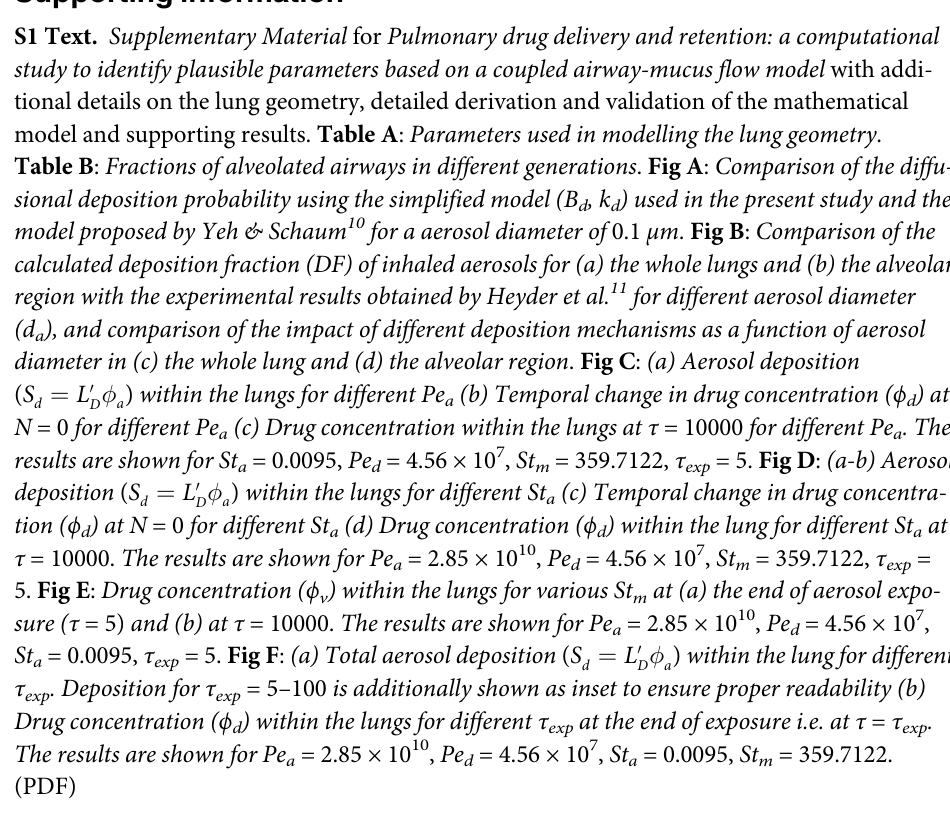
Table B : Fractions of alveolated airways in different generations . Fig A : Comparison of the diffu- sional deposition probability using the simplified model (B , k ) used in the present study and the d d model proposed by Yeh & Schaum 10 for a aerosol diameter of 0.1 μm . Fig B : Comparison of the calculated deposition fraction (DF) of inhaled aerosols for (a) the whole lungs and (b) the alveolar region with the experimental results obtained by Heyder et al. 11 for different aerosol diameter (d ), and comparison of the impact of different deposition mechanisms as a function of aerosol a diameter in (c) the whole lung and (d) the alveolar region . Fig C : (a) Aerosol deposition ( S ¼ L 0 � ) within the lungs for different Pe (b) Temporal change in drug concentration (ϕ ) at a d d a D N = 0 for different Pe (c) Drug concentration within the lungs at τ = 10000 for different Pe . The a a = 0.0095, Pe = 4.56 × 10 7 , St = 359.7122, τ = 5. Fig D : (a-b) Aerosol results are shown for St a d m exp ¼ L 0 � ) within the lungs for different St deposition ( S (c) Temporal change in drug concentra- a d a D tion (ϕ ) at N = 0 for different St (d) Drug concentration (ϕ ) within the lung for different St at d a d a = 2.85 × 10 10 , Pe = 4.56 × 10 7 , St = 359.7122, τ = τ = 10000. The results are shown for Pe a d m exp 5. Fig E : Drug concentration (ϕ ) within the lungs for various St at (a) the end of aerosol expo- v m = 2.85 × 10 10 , Pe = 4.56 × 10 7 , sure (τ = 5) and (b) at τ = 10000. The results are shown for Pe a d = 0.0095, τ = 5. Fig F : (a) Total aerosol deposition ( S ¼ L 0 � ) within the lung for different St a exp d a D = 5–100 is additionally shown as inset to ensure proper readability (b) τ . Deposition for τ exp exp Drug concentration (ϕ ) within the lungs for different τ at the end of exposure i.e. at τ = τ . d exp exp = 2.85 × 10 10 , Pe = 4.56 × 10 7 , St = 0.0095, St = The results are shown for Pe a d a m